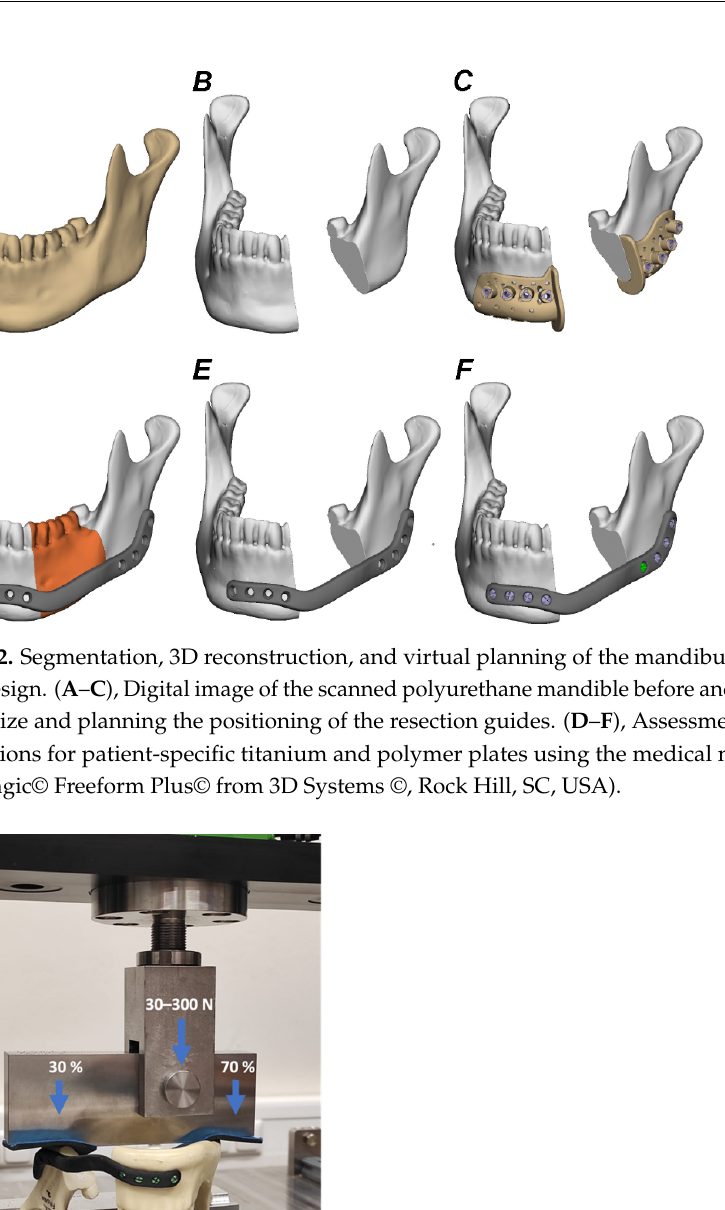
Figure 3 . Display of servo ‐ hydraulic mechanical testing with a MTS Bionix (Eden Prairie, MN, USA) testing machine. Cyclical loading of bite forces between 30 and 300 N with distribution of 30% of maximum force on the resected and 70% on the unresected side of the mandible.